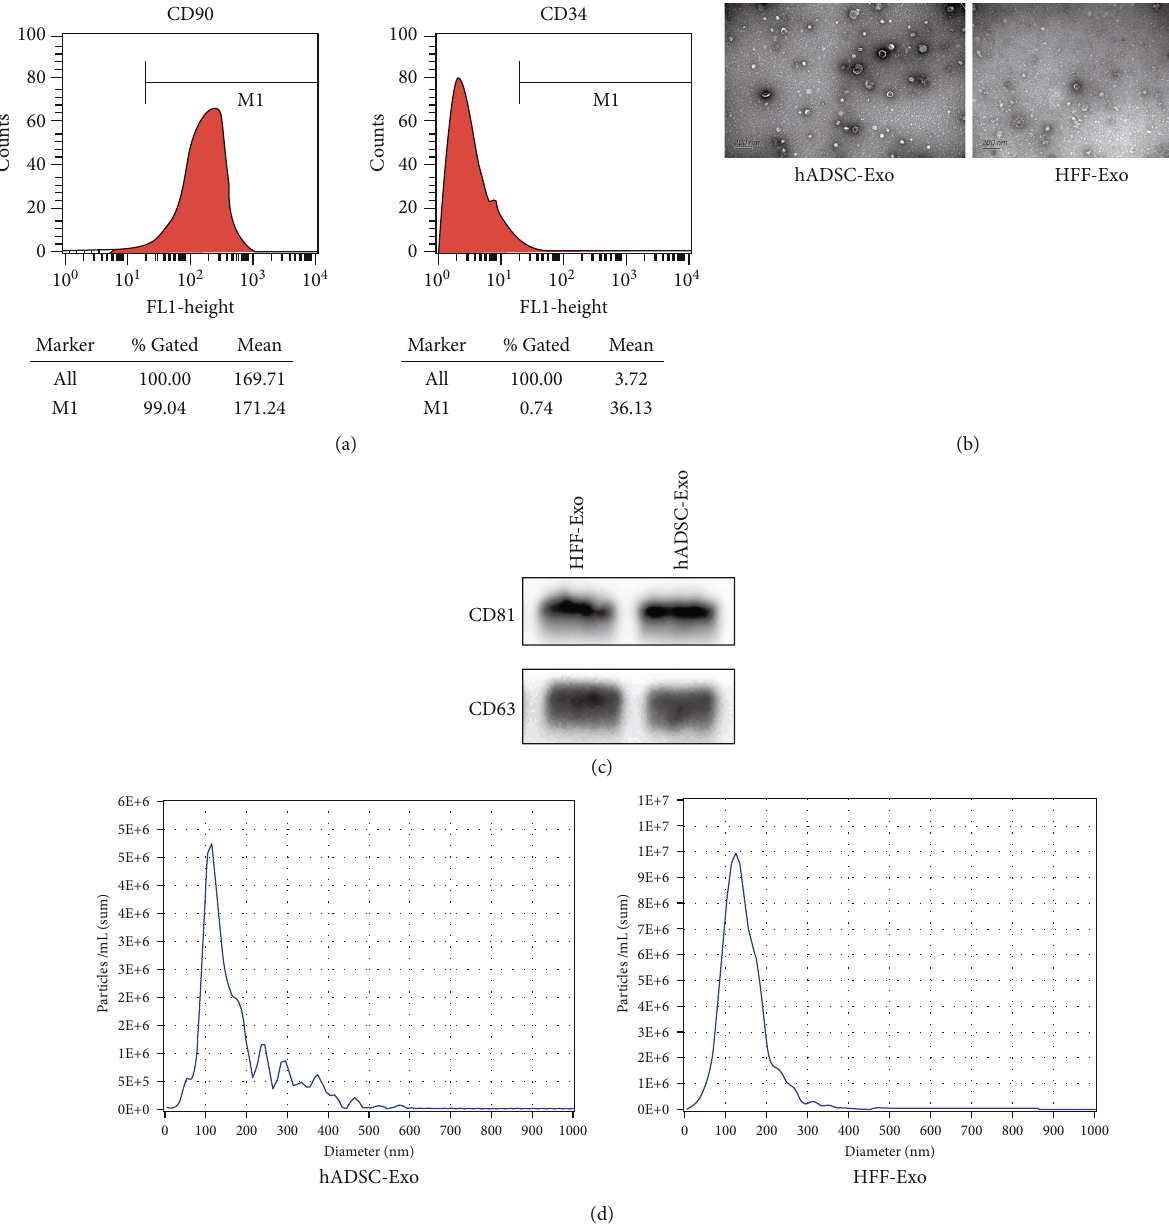
Figure 1: Identi fi cation of hADSC, hADSC-Exo, and HFF-Exo. (a) Flow cytometry analysis of cell surface marker CD90 and CD34 was showed in hADSC. (b) The image of exosome was showed through TEM. (c) Western blotting veri fi ed the expression of CD63 and CD81 in hADSC-Exo and HFF-Exo. (d) NTA measured the size distributions of hADSC-Exo and